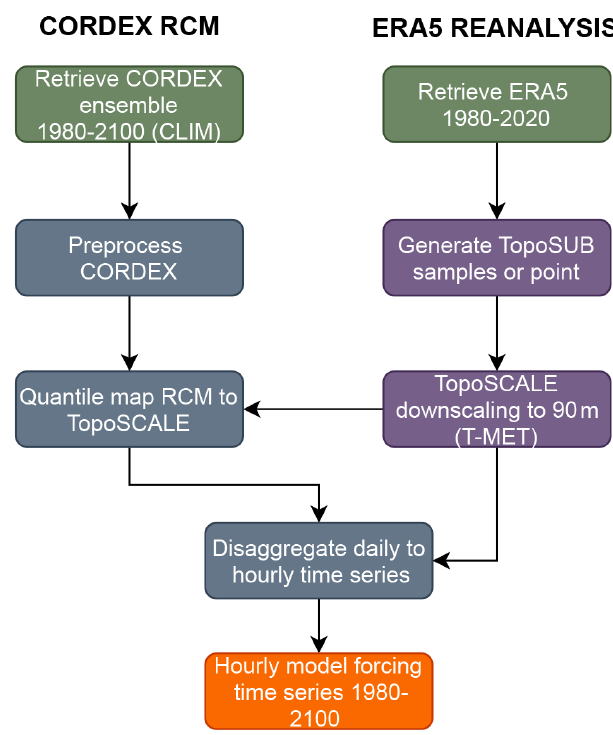
Figure 1. Schematic overview of the main TopoCLIM processes and the experimental setup used in this